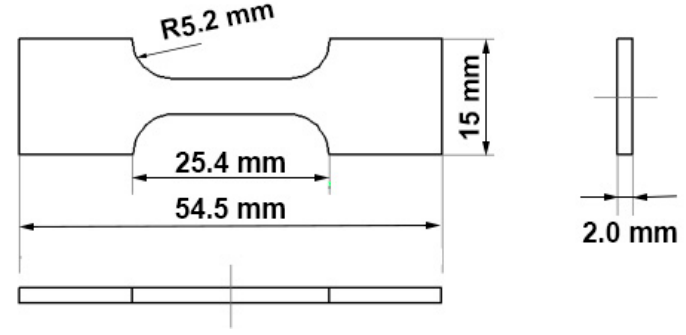
Figure 1. The scheme and dimensions of the samples for tensile tests.